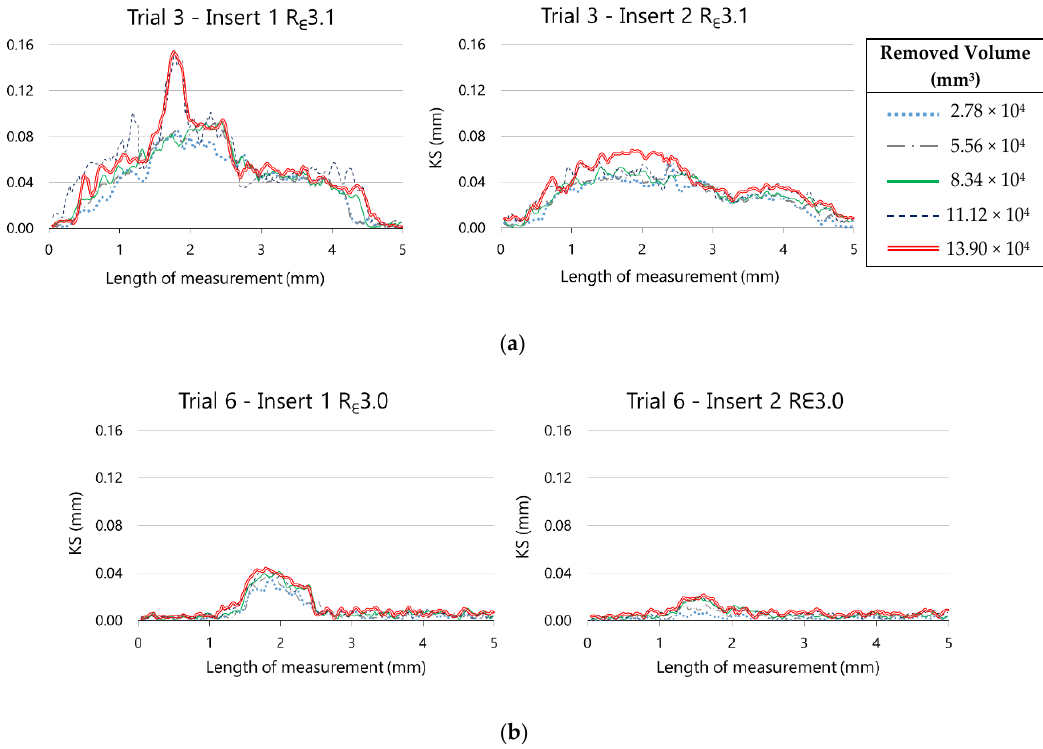
Figure 19. Evolution of the radial flank along the cutting edge on ( a ) R ᗴ 3.1 inserts and ( b ) R ᗴ 3.0 inserts. In both experiments, the behaviour of VB radial with R ᗴ 3.1 and R ᗴ 3.0 is similar between inserts 1 and 2. The maximum value of VB radial for insert 1 is bigger than for insert 2, as much for R ᗴ 3.1 as for R ᗴ 3.1. This representation allows us not only to compare the maximum value of both inserts in a tool but also to compare the extension of the wear along the cutting edge. We can observe also the evolution of radial flank wear along the cutting edge to the extent that material is removed. showed in Figure 20.